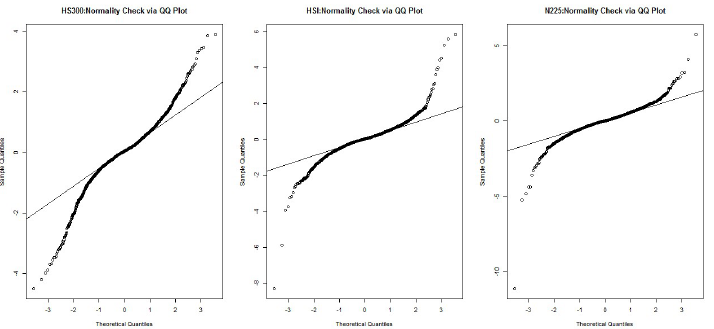
Fig. 2 QQ diagram of sample